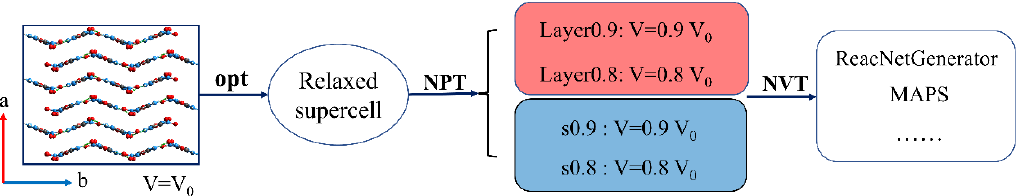
Figure 1. The schematic diagram of the simulation process. The red and blue color means the com- pression along c direction and b direction,